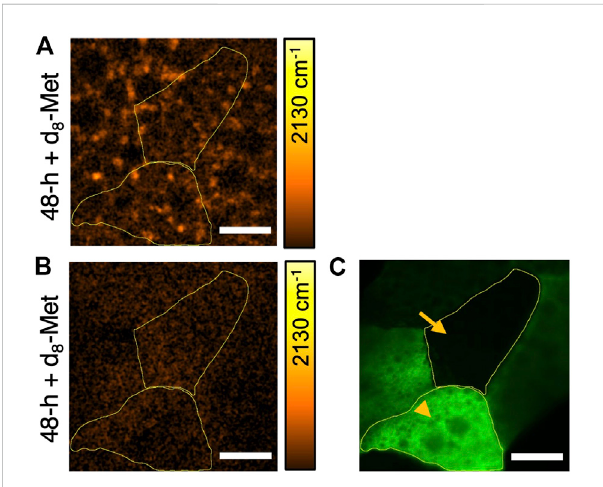
FIGURE 5 The uptake of d 8 -Met in the Drosophila larval fat body can vary according to genotype. d 8 -Met uptake (orange) in control (A) and TorTED expressingfatbodytissue (B) .The fl ip-outtechniquehasbeen used to direct TorTED expression in GFP marked cells (green) (C) and demarcated areas (yellow boundaries) correspond to regions of interest (ROI), ROI1 (arrowhead) and ROI2 (arrow). Note that (B) and (C) correspondstothesametissueandsame fi eldofview.Theaverage d 8 -Met concentrations in ROI1 and ROI2 are (A) 3.68 mM and 3.34 mM, (B) 1.97 mM and 2.48 mM, respectively. The color bars corresponding to the d 8 -Met concentration shows a maximum value of 51 mM, Scale bars, 20 μ